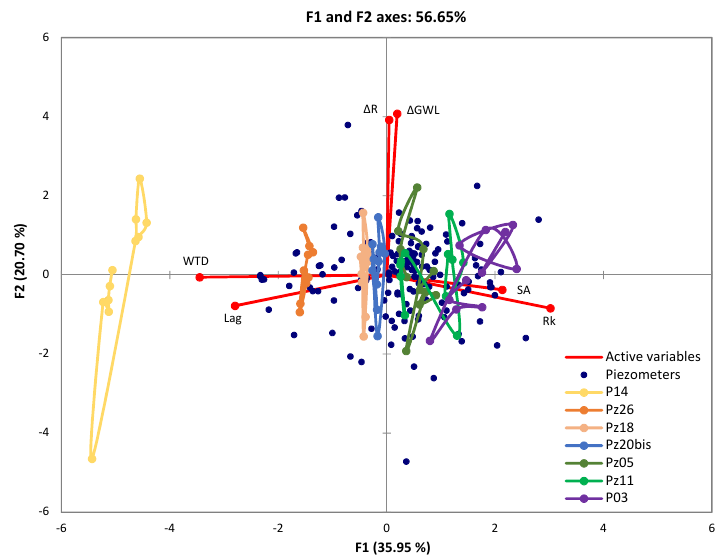
Figure 8. PCA of spatial and temporal heterogeneity of the aquifer behavior with a representative sample of piezometers. Analysis with six active variables ( Lag , WTD , R k , SA , Δ R , and Δ GWL ). The results from the PCA concur with the preceding analyses in Sections 3.4.1 and 3.4.2. Indeed,